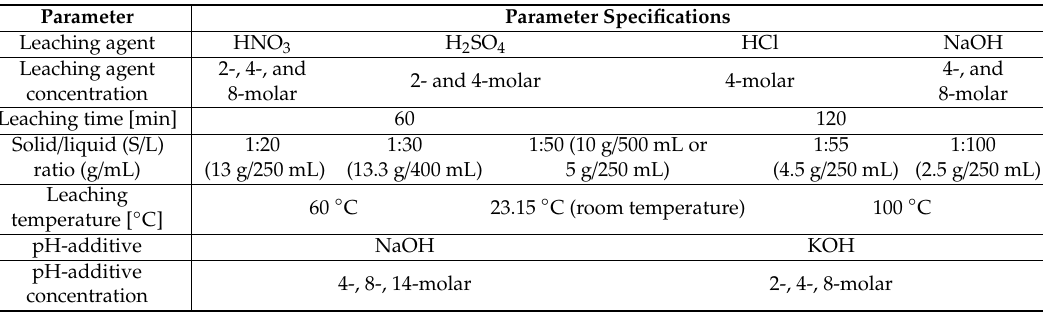
Table 2. Overview of the parameters used in this study. The leaching agent columns match the leachate concentration columns. The pH additive columns match the pH additive concentrations. Other columns are not to read as matching parameter specifications, e.g., HNO 3 as leaching agent can also comprise trials with a 120 min leaching